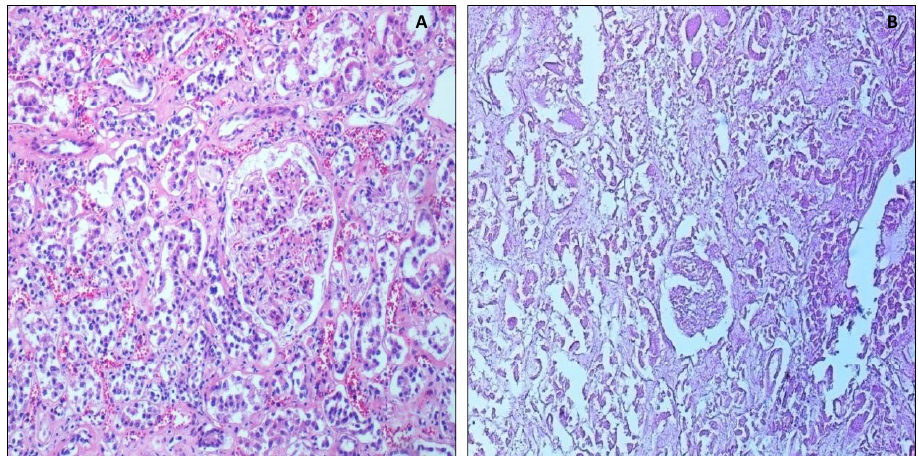
Figure 2. Morphological analysis of kidney. ( A ) Image displays well preserved glomeruli and tubules 1 day after death, 10×. ( B ) Disgregated glomeruli and tubules 2 years after death, 10×.